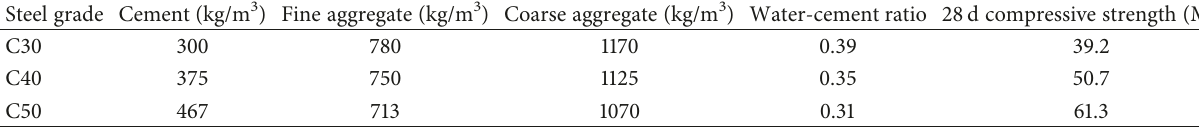
Table 3: Mixing proportion and 28-day compressive strength of the concrete samples.